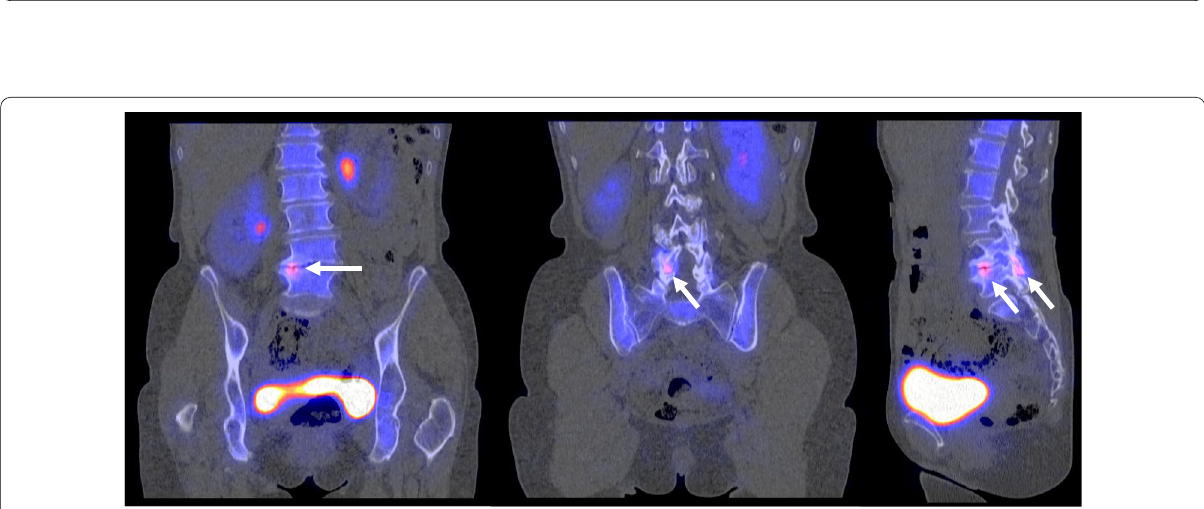
Fig. 6 SPECT/CT of an FBSS patient using Tc-99m HDP to investigate the cause of persistent pain after left-sided laminectomy at level L5–S1. Focal radiotracer accumulation was observed at level L4–L5, both near the intervertebral disk and the right zygapophyseal joint. Tracer accumulation was considered to reflect active osteoarthritic changes. No reoperation was carried